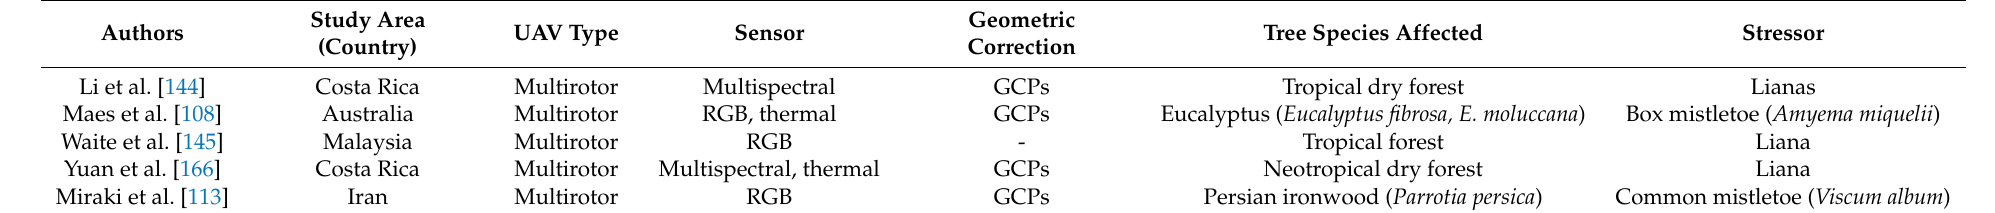
Table A3. Phytoparasites: reviewed articles regarding phytoparasites as a cause of tree